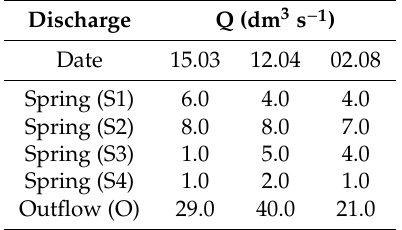
Table 3. E ffi ciency of the springs and discharge of the outflow from the lake in